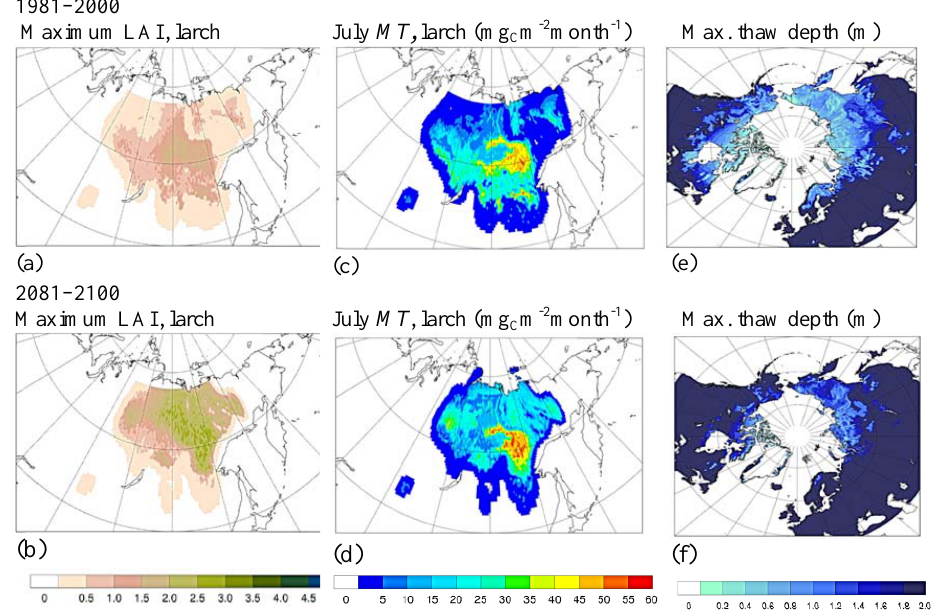
Figure 1. Simulated maximum summer monthly leaf area index (LAI; a, b ) and July emissions of monoterpenes ( c, d ; mgCm − 2 month − 1 ) from Eastern Siberian larch. The latter were calculated applying emission factors of 6.2, obtained from the measurements at Spasskaya Pad. (e, f) Maximum permafrost thaw depth (August), shown here as the circumpolar map for comparison with Tarnocai et al. (2009). Values are averages for a simulation 1981–2000 (a, c, e) and for 2081–2100 (b, d, f) , applying climate and CO 2 concentrations from ECHAM-RCP8.5. Emissions in (c, d) do not account for direct CO 2 inhibition (see also Fig.